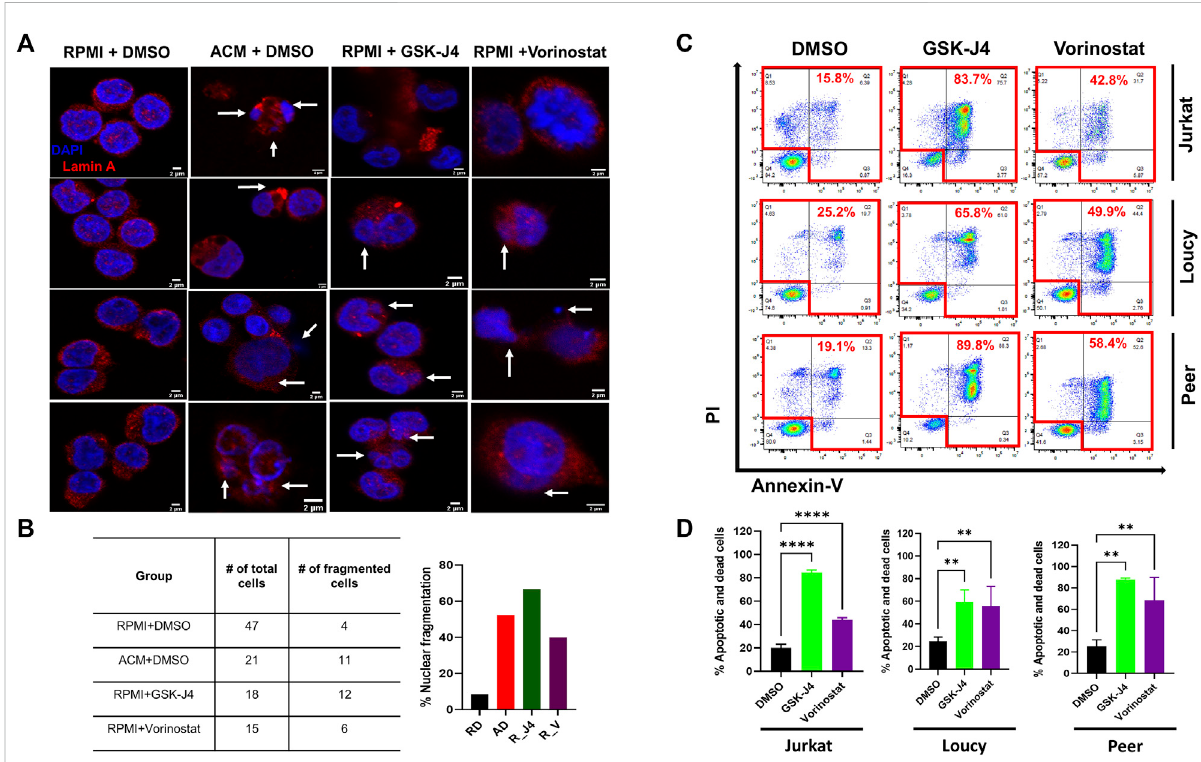
FIGURE 6 Treating human T-ALL cells with GSK-J4 and vorinostat phenocopy ACM-induced DNA damage and cytotoxicity in leukemia cells. Jurkat TcellswereculturedinRPMI+DMSO,ACM+DMSO,orwithRPMI+epigeneticmodifyingdrugs(GSK-J4orVorinostat)for48 h.Thecellswerethen stained with lamin A with DAPI to visualize nuclei. (A) Representative images are shown with white arrows indicating nuclei spillage or fragmented nuclei. The percentage of cells harboring fragment nuclei, calculated by dividing the # of cells containing fragmented nuclei/total # of cell counted, is shown in (B) . (C,D) Human T-ALL cells (Jurkat, Loucy, and Peer) were treated with DMSO (control), GSK-J4 (a histone demethylase inhibitor), or vorinostat (a histone deacetylase inhibitor) for 72 h. The percentage of dead cells after 3 days of treatment was determined using Annexin-V/PI staining fl ow by fl ow cytometry. Representative primary data from one of three independent experiments are shown in (C) with quantitative data from combined experiments presented in (D) . Statistical signi fi cance was calculated using a one-way ANOVA followed by Tukey ’